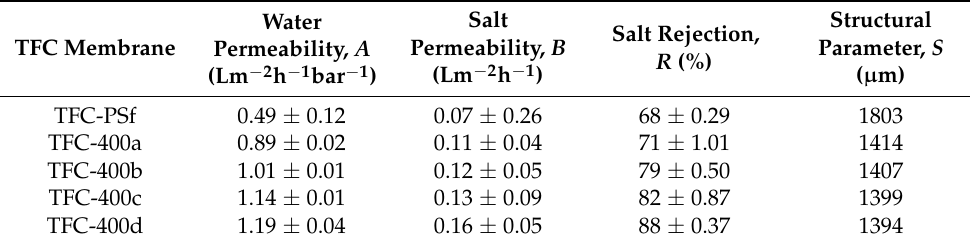
Table 3. Intrinsic properties of the pristine TFC-PSf membrane and modified TFC membranes with PEG